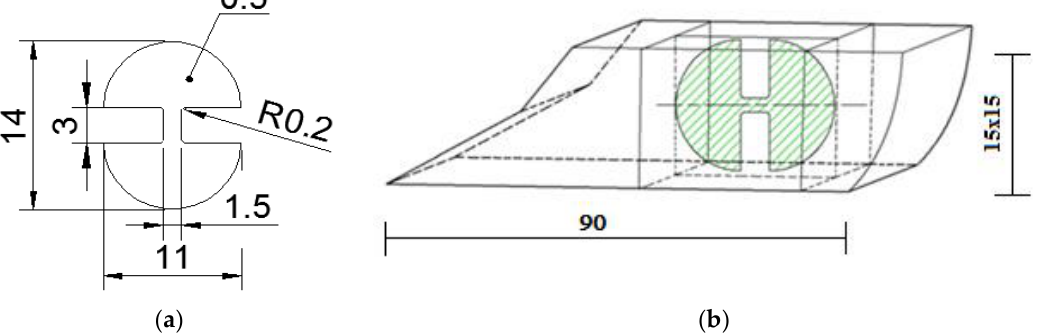
Figure 3. The sample prepared for tensile testing: scheme of the specimen ( a ) and scheme of removal of small samples ( b ).